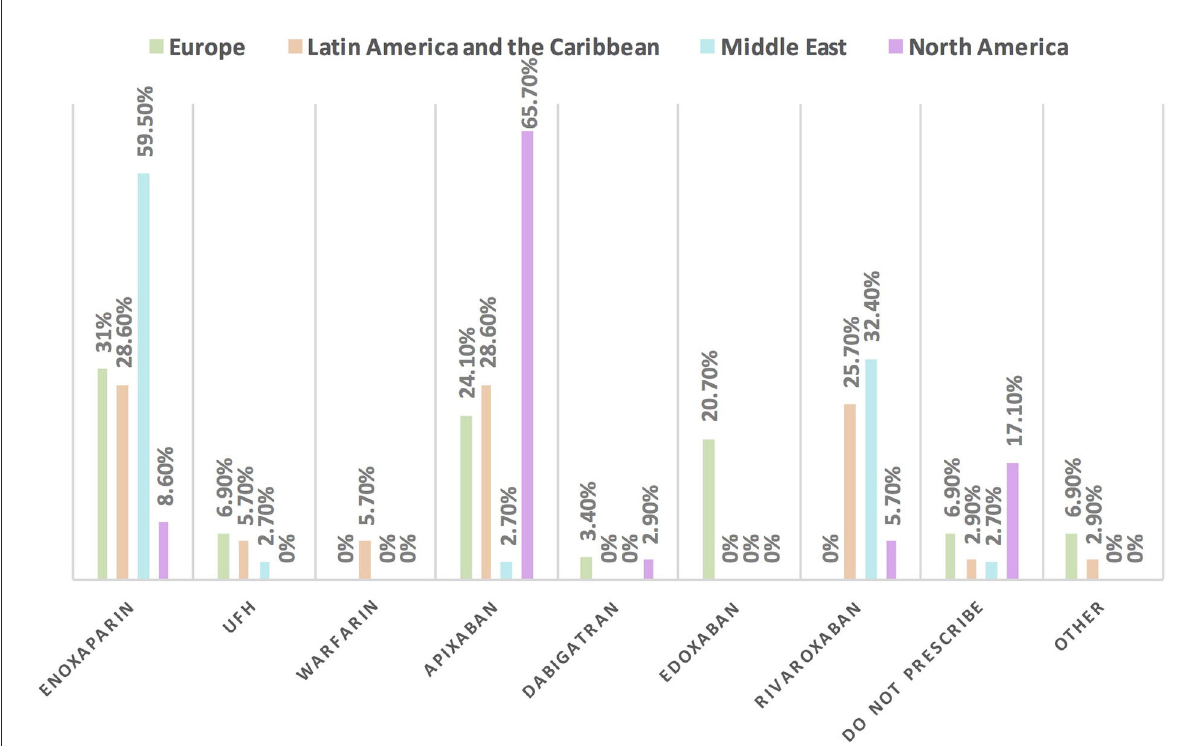
FIGURE12 The most commonly prescribed anticoagulant for patients with cancer and COVID-19 infection in different continents. Enoxaparin is the most commonly prescribed anticoagulant in patients with cancer and COVID-19 infection, unlike in North America where apixaban is the main one. UFH, unfractionated